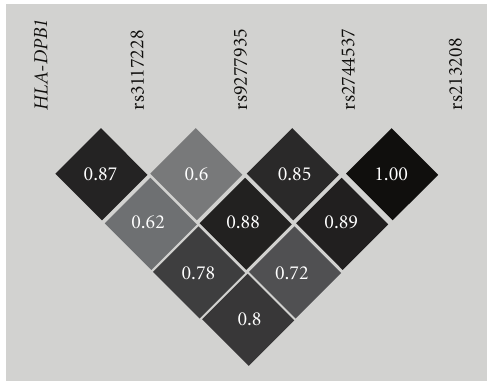
Figure 2: LD between WG associated variations of the 6p21.3 genomic region. HLA-DPB1 is modelled as a biallelic marker with the associated HLA-DPB1 ∗ 0401 as one allele and all other alleles joint into the other allelic category. LD is plotted as D (cid:3) and intensity coded (darker shades corresponding to higher degree of LD). Both RXRB SNPs investigated in this study (rs9277935 and rs2744537) are in high LD with HLA-DPB1 as well as with the markers analyzed by Heckmann et al. (2008): rs3117228 (3 (cid:3) of HLA-DPB1 ) and rs213208 (intronic SNP in RING1 , approx. 10kb centromeric of RXRB